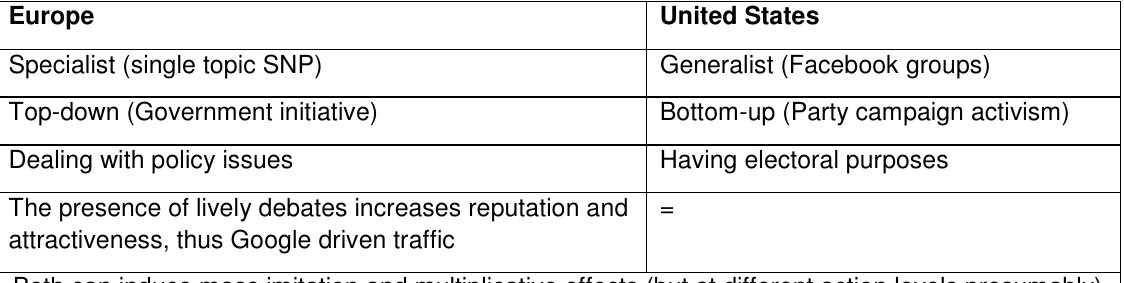
Table 4: Political Social Networking Orientation in Europe and the US